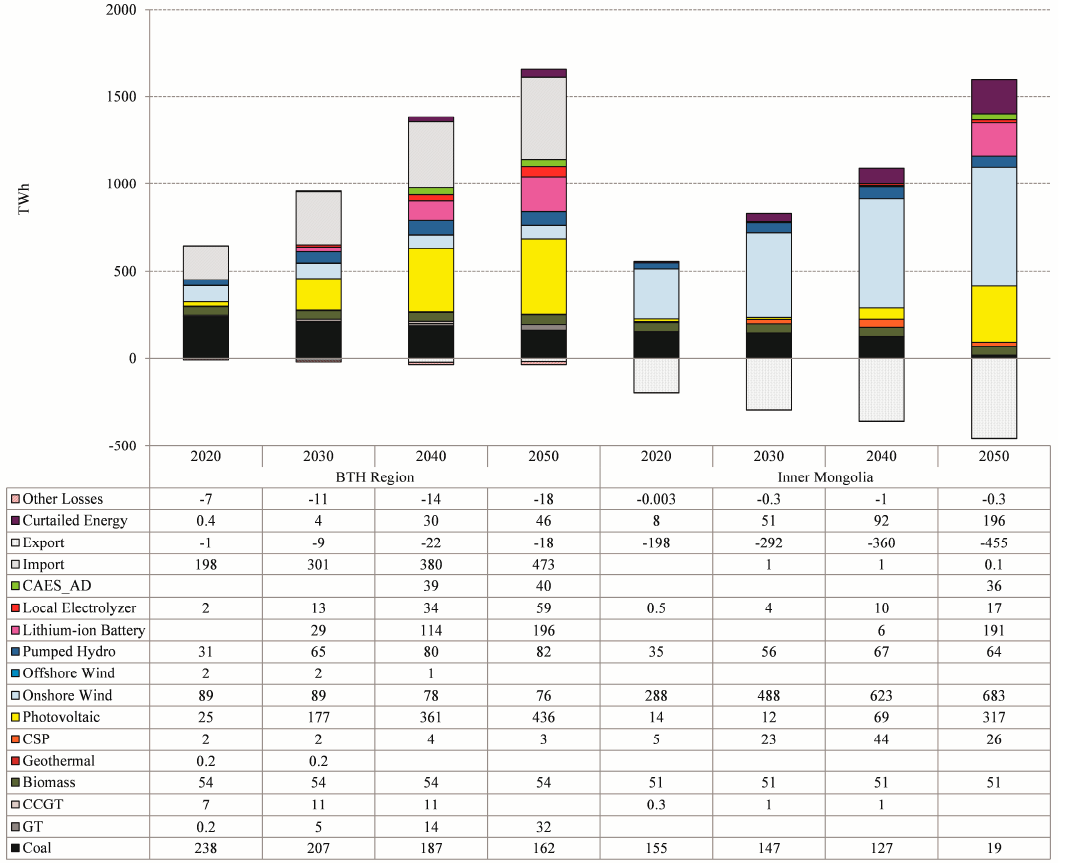
Figure 12. Annual power supply for the metropolitan and the supply region from 2020 to 2050.